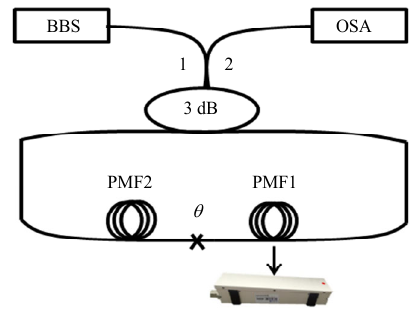
Fig. 5 Experimental setup diagram.